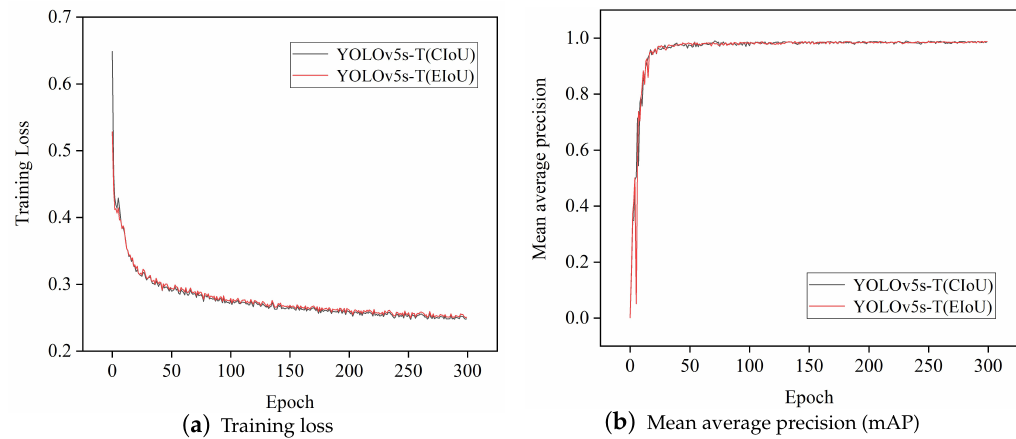
Figure 7. Training loss and mAP of the proposed